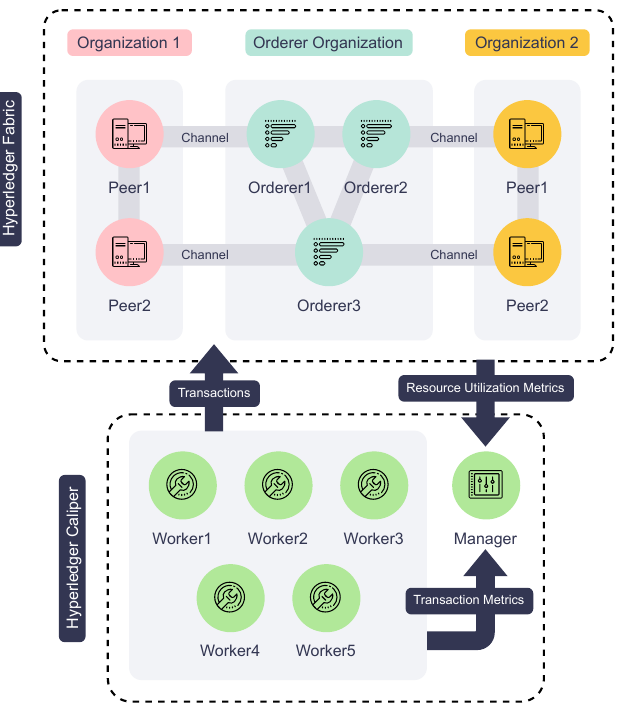
Figure 8. IoT service platform testbed